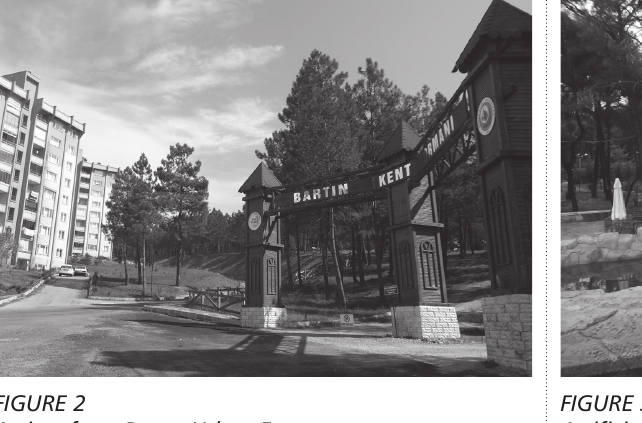
A view from Bartın Urban Forest Artificial facilities in Kepez/Antalya Urban Forest in Turkey should be 45 ha. This implies that 13 out of 52 urban forests are below the minimum size (Table 3). Urban Forest Infrastructure